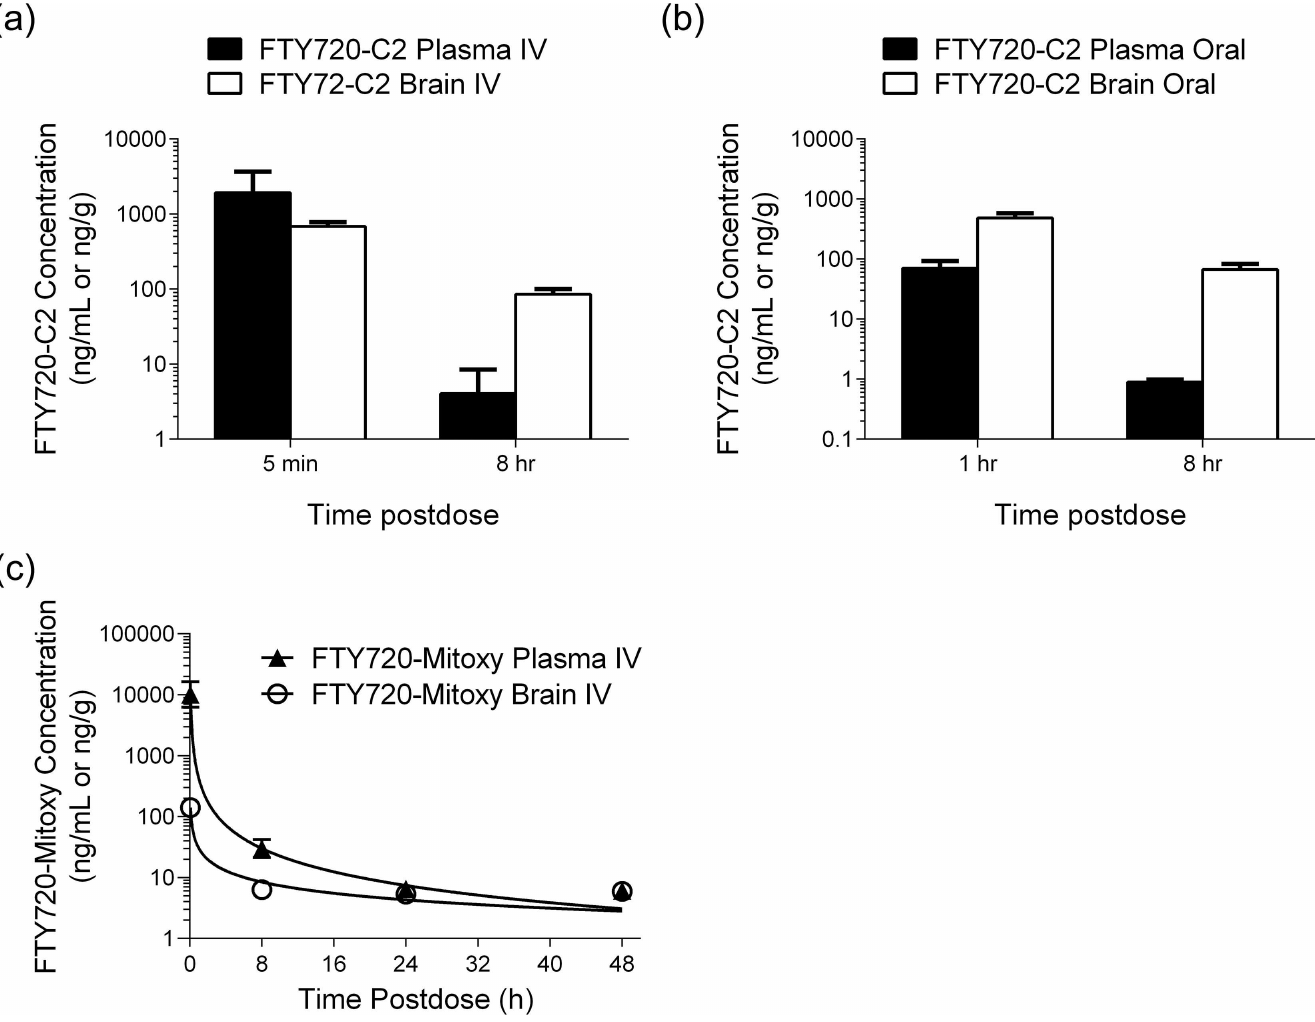
Fig 5. Plasma and BrainFTY720-C2 and FTY720-Mitoxy concentrationprofiles. Mean plasmaand brain concentrations of FTY720-C2 afterIV dosing ( a ) and oral dosing( b ) (black bar = plasma;white bar = brain);and of FTY720-Mitoxy afterIV dosing ( c ) ( ▲ = plasma; (cid:14) = brain).Units are in ng/mL for plasmaand ng/g for brain. Data representthe mean ± SD of two experiments for each time point.Errorbars were calculatedfor all samples and are presenton the graphs. However, for sampleswith littlevariabilityerrorbars do not extend beyond the edges of the symbols so thus, are not